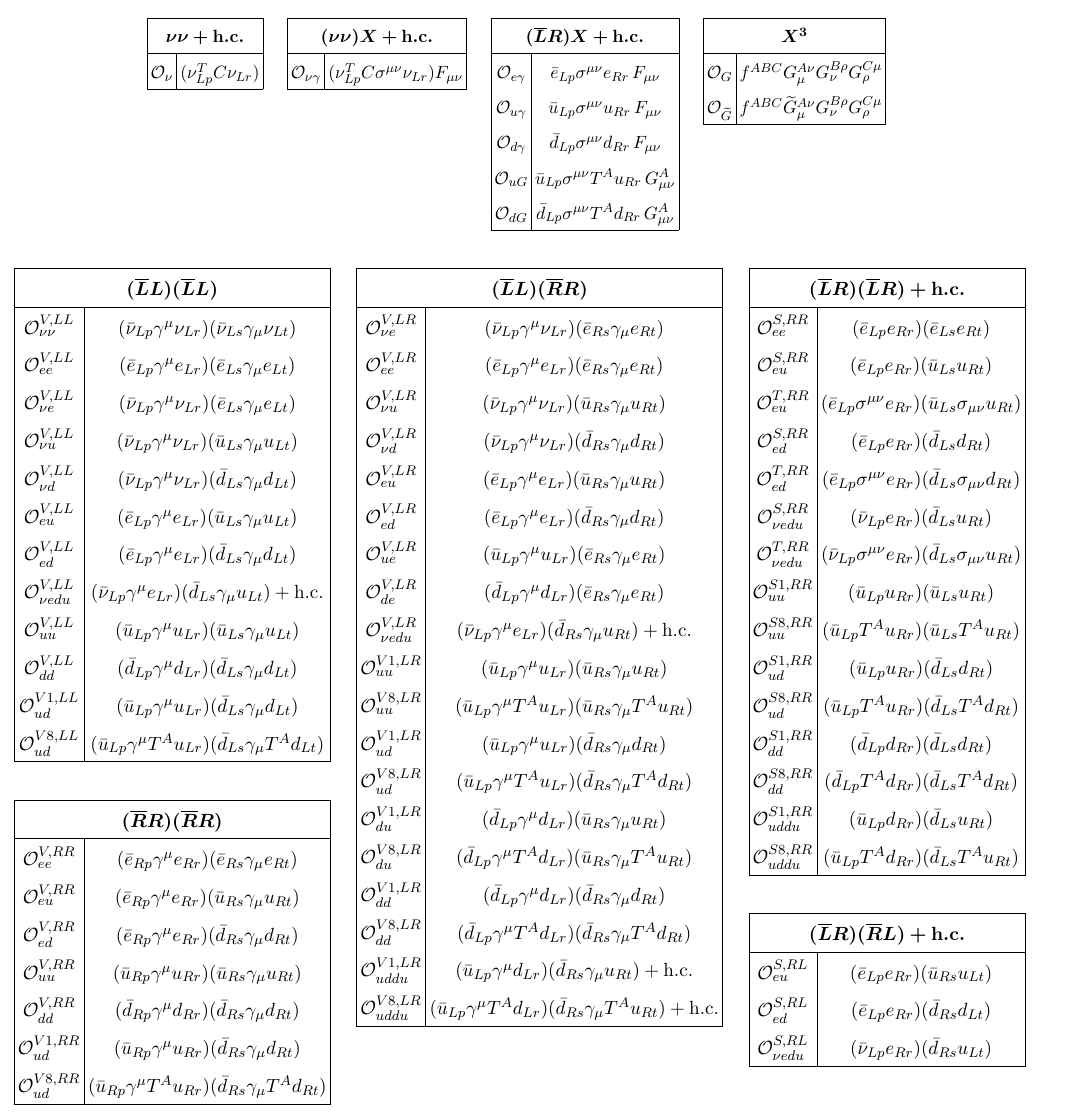
Table 7 . The operators for LEFT of dimension three, five, and six that conserve baryon and lepton number, and the dimension-three and dimension-five ∆ L = 2 operators. The dimension-three ± ∆ L = 2 operator is the Majorana-neutrino mass operator, while the dimension-five ∆ L = 2 O ν operator is the Majorana-neutrino dipole operator. There are 5 additional dimension-five O νγ dipole operators (¯ LR ) X . The 80 dimension-six operators consist of 2 pure gauge operators X 3 and 78 four-fermion operators ψ 4 , which are further divided by their chiral structure. The ψ 4 operator superscripts V , S , T refer to products of vector, scalar, and tensor fermion bilinears, and the additional two labels L or R refer to the chiral projectors in the bilinears. Operators with +h . c . have Hermitian conjugates. The subscripts p, r, s, t are weak-eigenstate